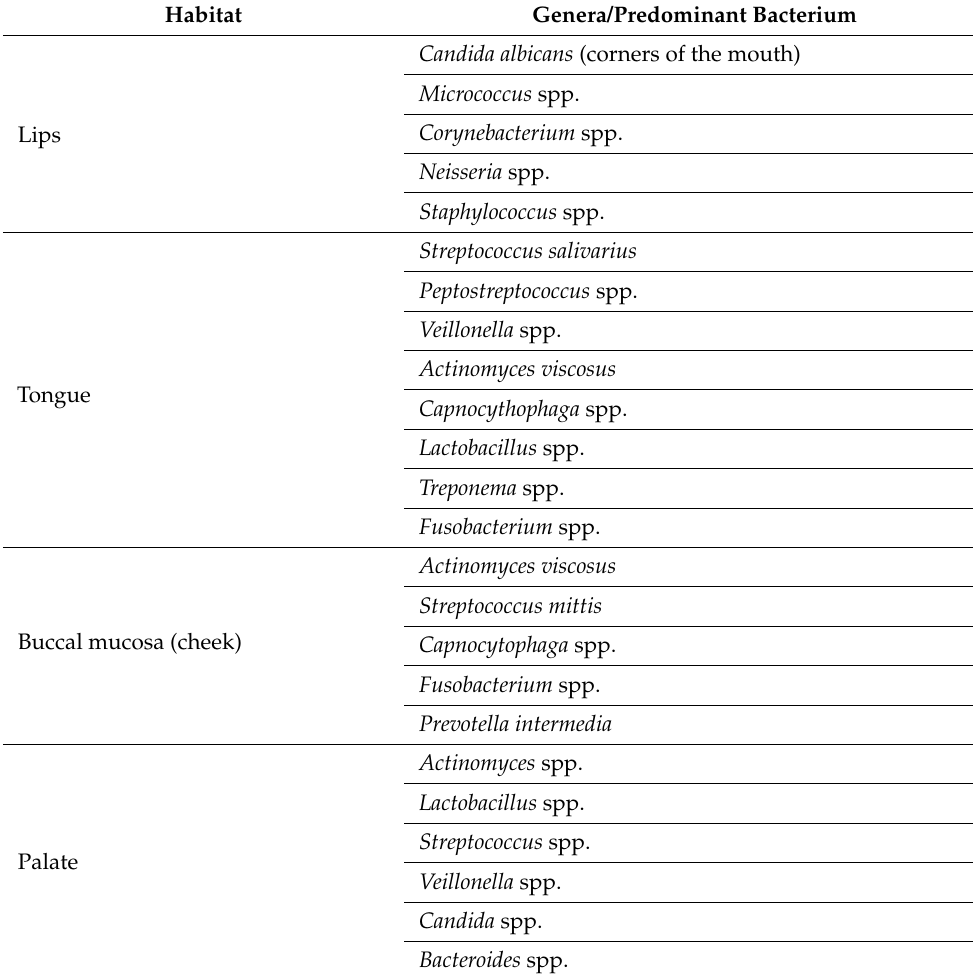
Table 1. The most common microflora in the oral cavity of adults. Habitat Genera/Predominant Bacterium Candida albicans (corners of the mouth) Micrococcus Lips